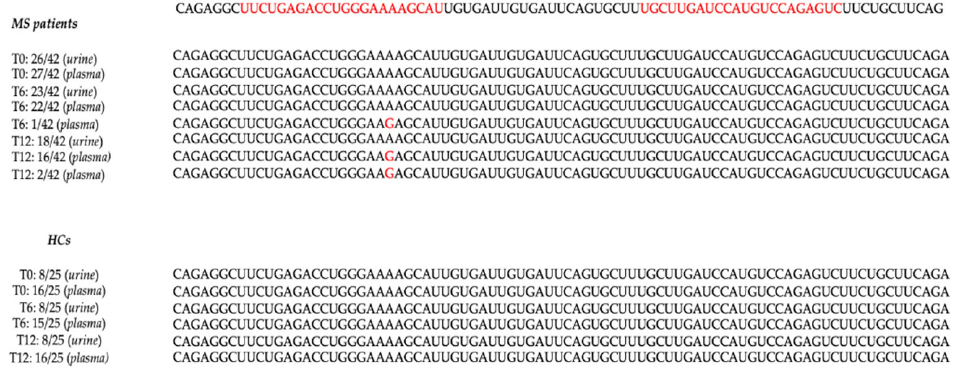
Figure 3. The miR-J1-5p mutations observed in JCPyV-DNA-positive MS specimens and in HCs. The mature miR-J1-3p and -5p are indicated (red color) by the bar over the sequence. The target region is indicated under the sequence. The JCV-miR-J1 sequence from miRBase V20 was used as